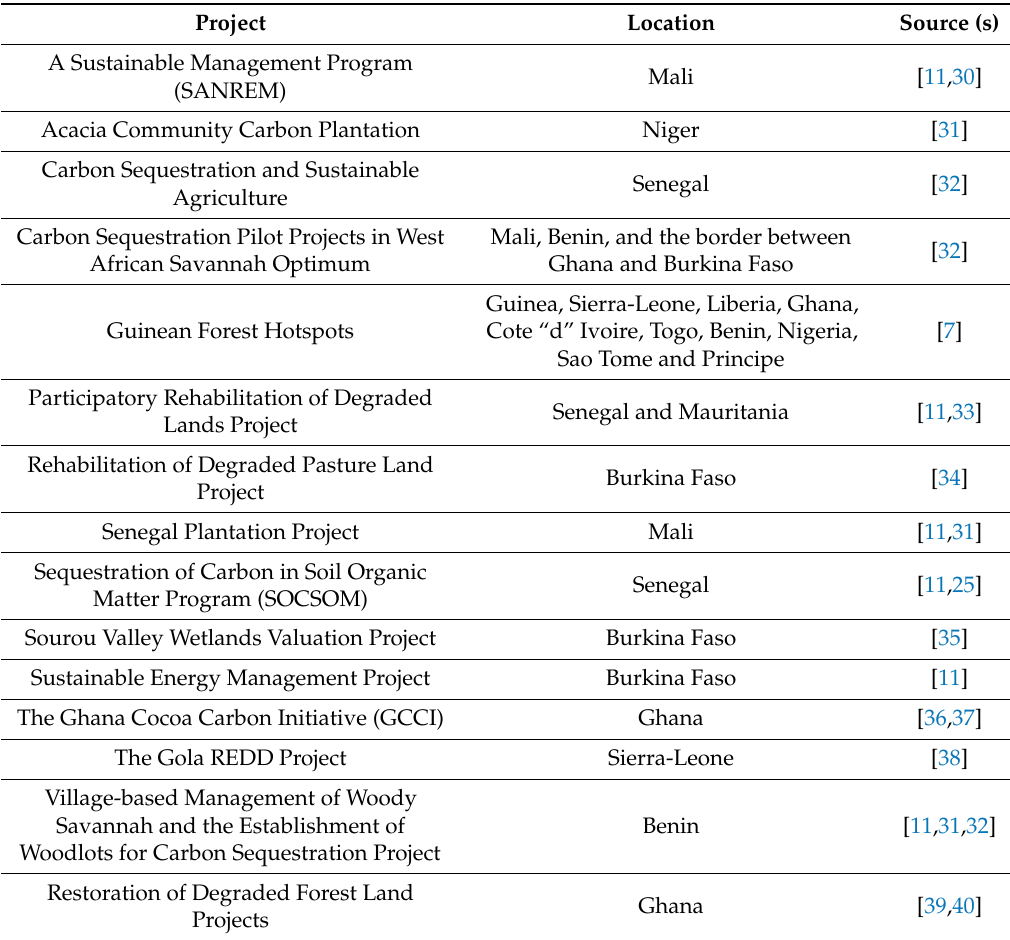
Table 2. Conservation Projects in West